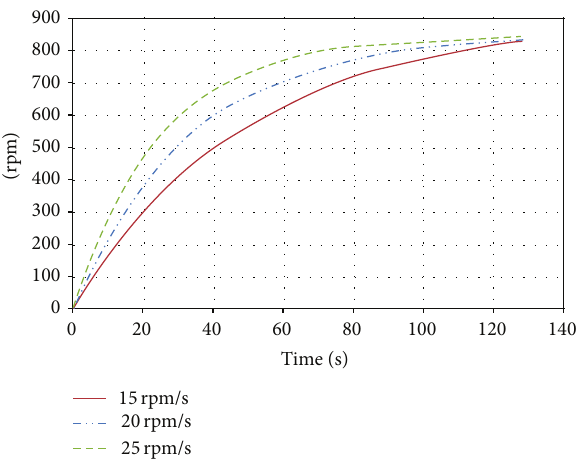
Figure 6: Diagram of rotation speed